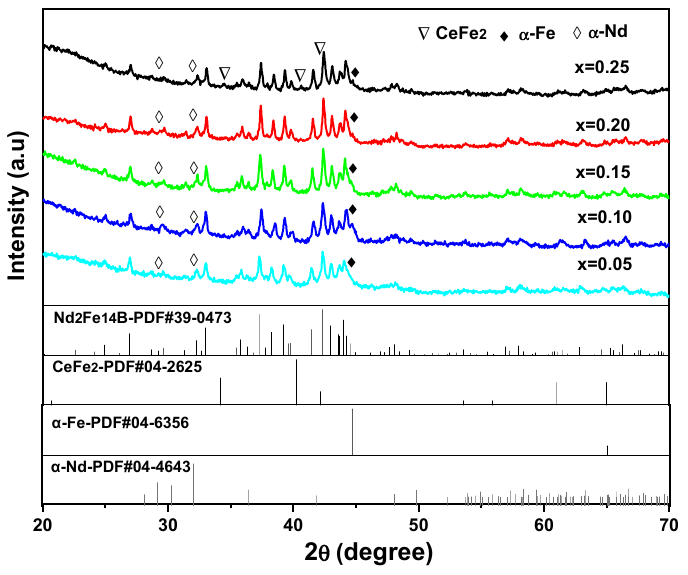
Figure 4. XRD patterns of (Nd 1-2x Ce x Y x ) 14.5 Fe 79.3 B 6.2 (x = 0.05, 0.10, 0.15, 0.20, 0.25) melt-spun ribbons.